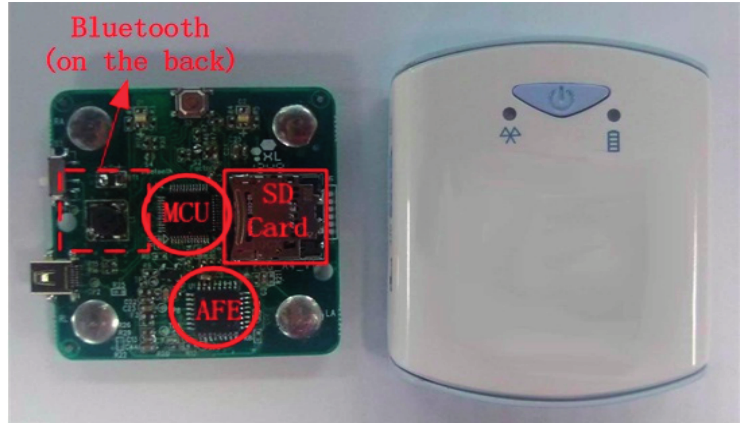
Figure 7. Photograph of proposed ECG Acquisition device.